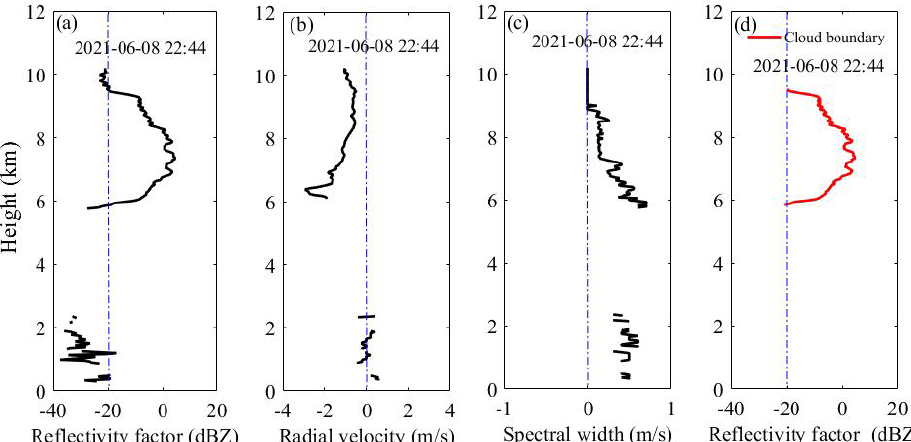
Figure 7. Meteorological signals of MMCR at 22:44CST on 8 June 2021. (a) Reflectivity factor, (b) radial velocity, (c) velocity spectrum width, and (d) reflectivity factor after quality